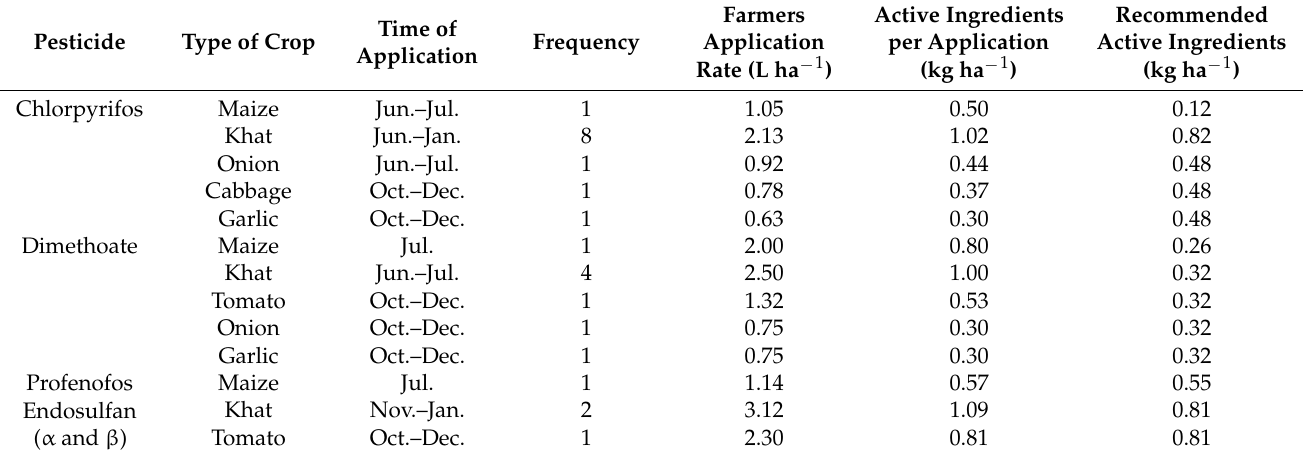
Table 1. Application rate and use of the major active ingredients in the applied pesticides during irrigation and rainfed cropping for different crops.